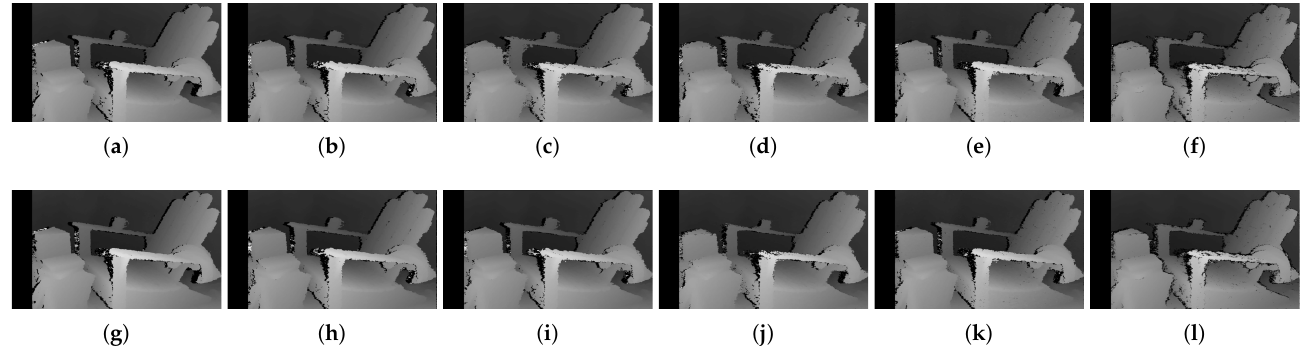
Figure 25. Estimated disparity images of the combinations of cost and image filter using the SGM stereo method, according to low and high gain parameter. The images in the top row show dis- parities at the low gain parameter, and the images in the bottom row show those at the high gain parameter, respectively. ( a ) SGM, AD. ( b ) SGM, Mean/AD. ( c ) SGM, LoG/AD. ( d ) SGM, BilSub/AD. ( e ) SGM, Rank/AD. ( f ) SGM, Census. ( g ) SGM, AD. ( h ) SGM, Mean/AD. ( i ) SGM, LoG/AD. ( j ) SGM, BilSub/AD. ( k ) SGM, Rank/AD. ( l ) SGM,